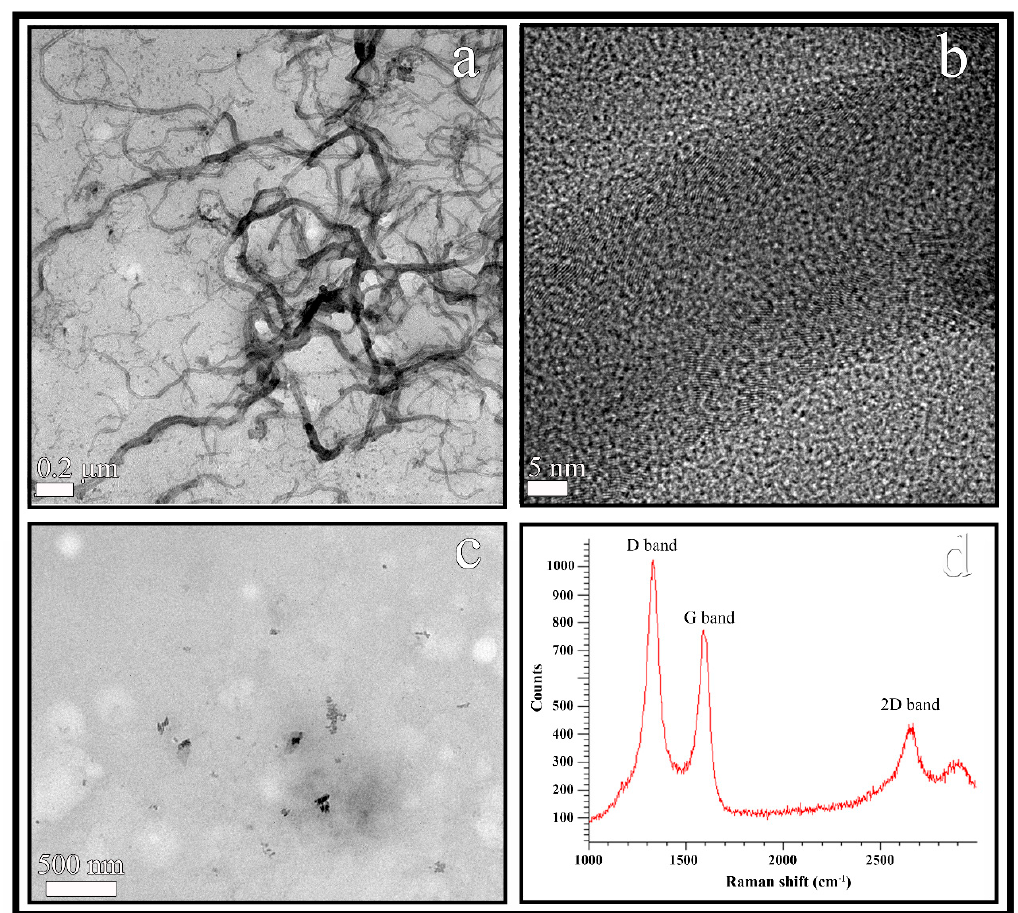
Figure 2. HR-TEM images of the carbon nanofibers at two different magnifications ( a , b ), TEM of cost- c ) and Raman spectrum of carbon nanofibers ( d effective calcium alginate/CNFs composite films ( c ) and Raman spectrum of carbon nanofibers ( d ). cost-effective calcium alginate/CNFs composite films (